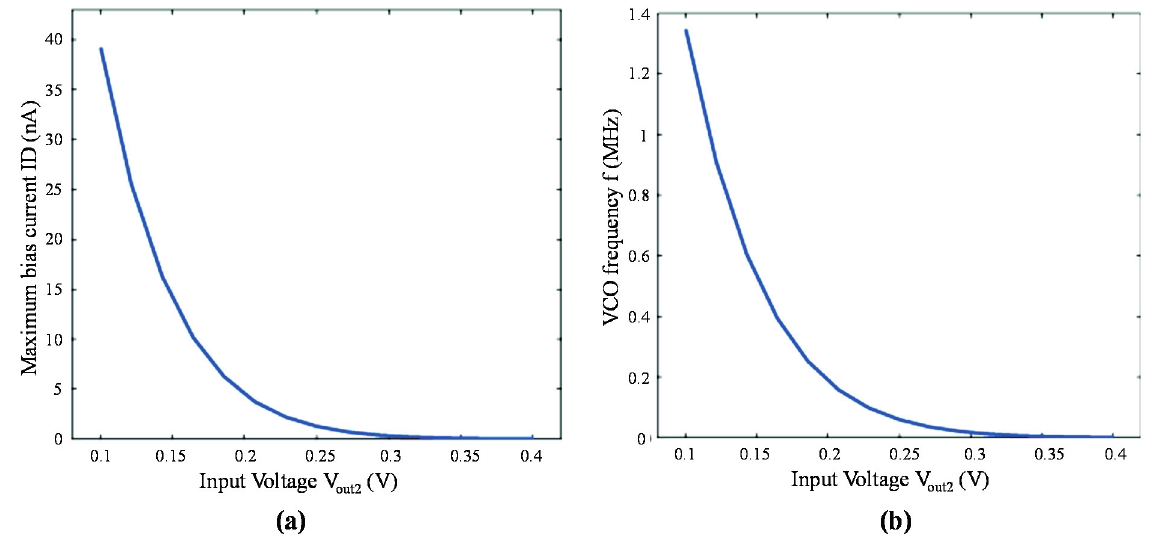
Figure 6. The simulation results of ( a ) the maximum bias current I D and ( b ) the VCO frequency as functions of bias voltage V out 2 .